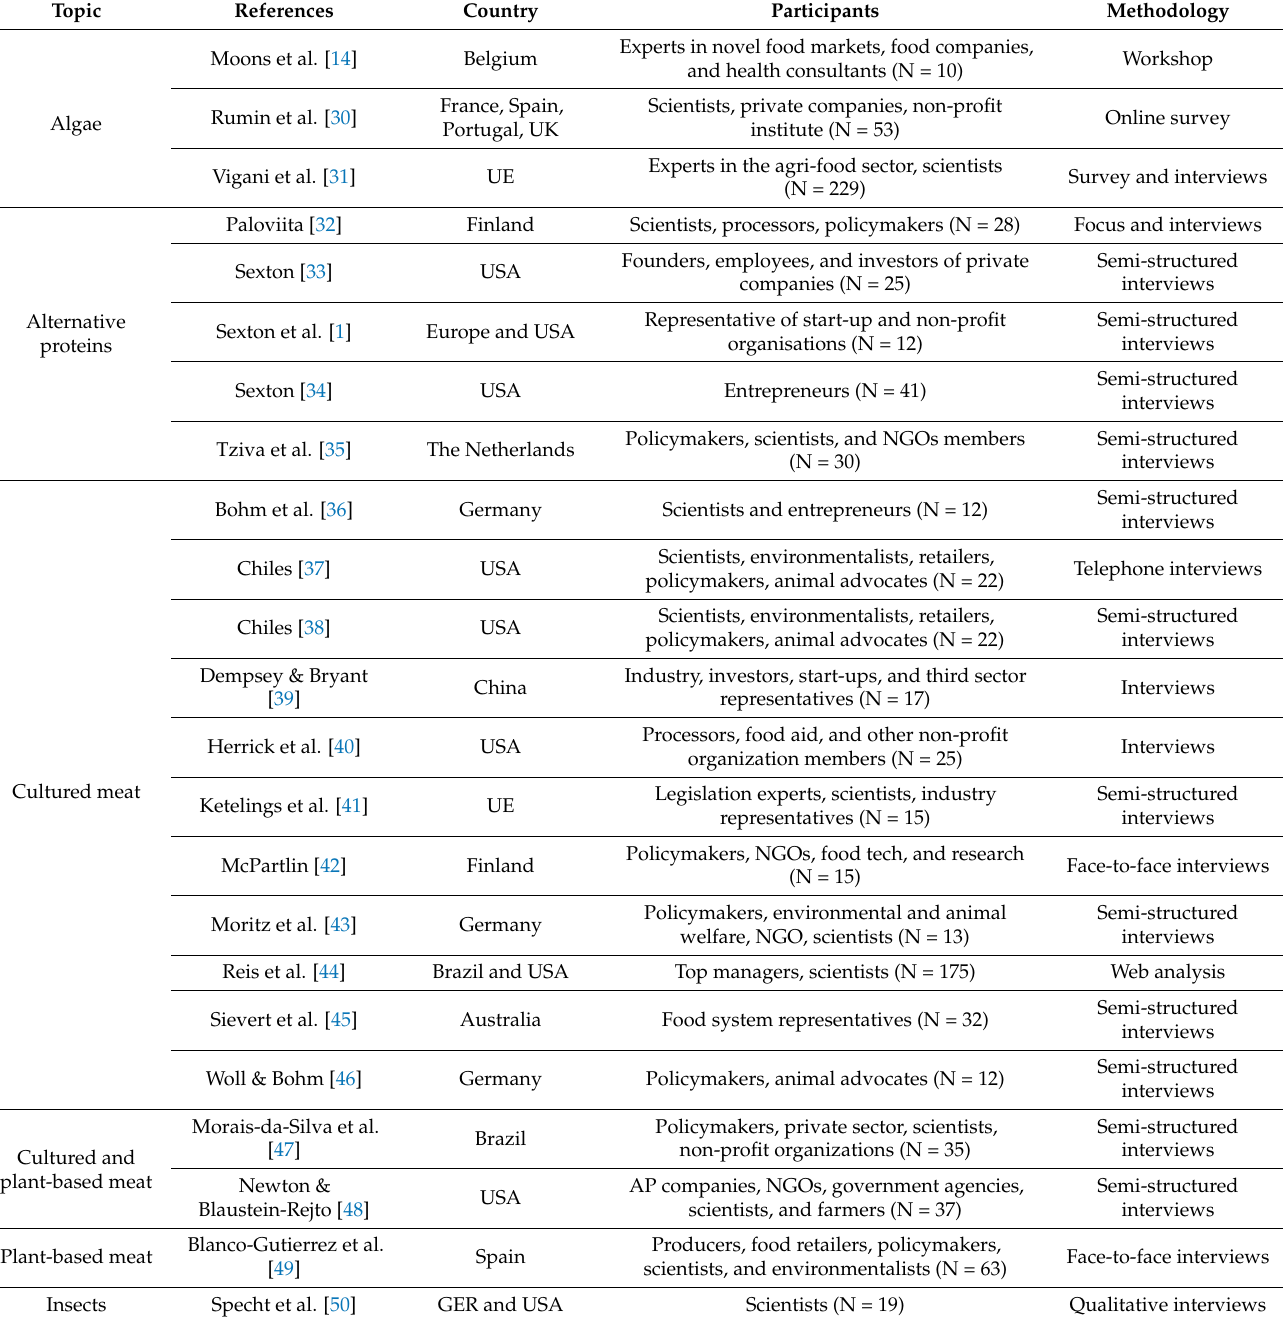
Table 1. List of papers